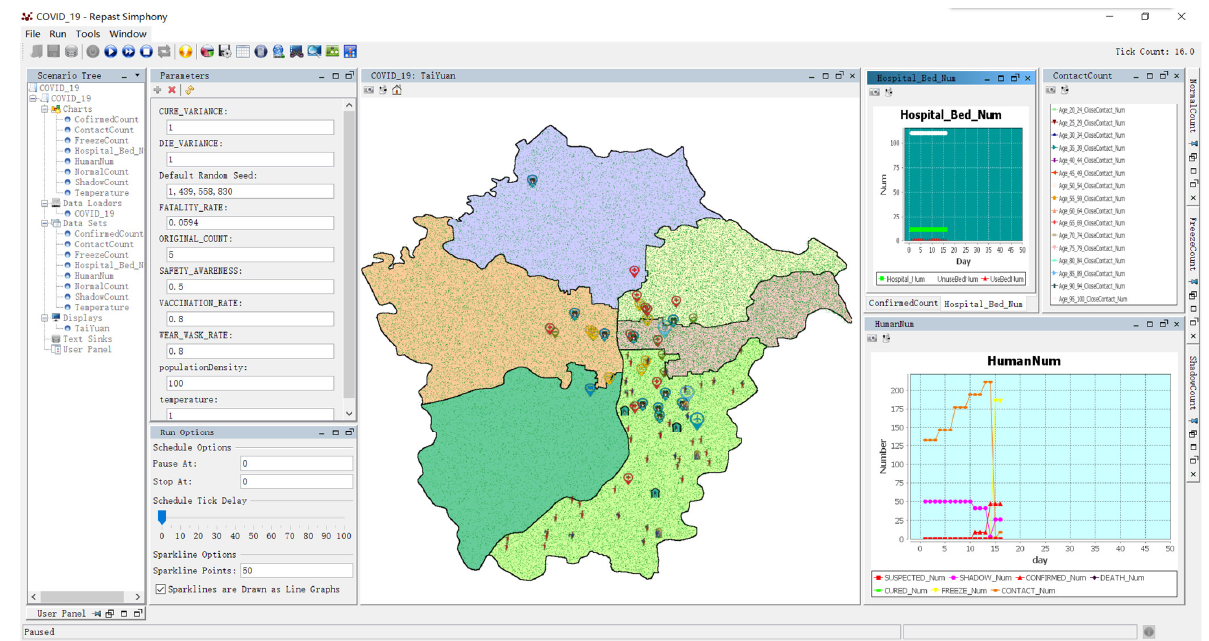
Figure 6. Model operating interface.